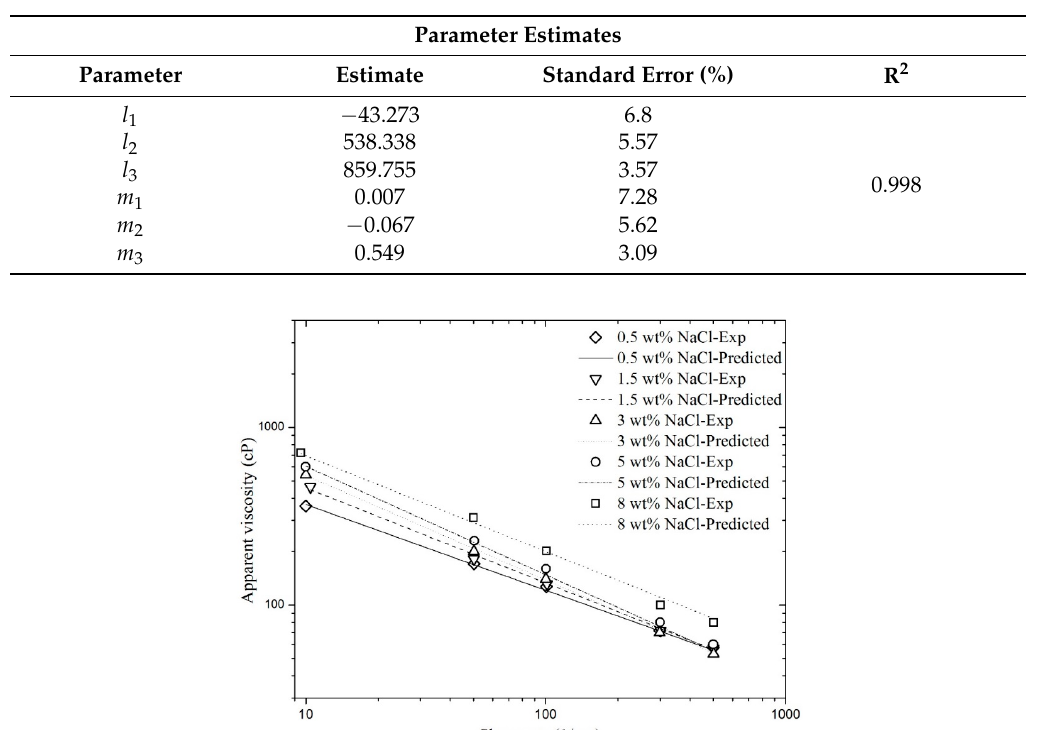
Table 4. Parameter estimates of viscosity correlation Equation (9) for CO 2 foam as a function of temperature and shear rate .